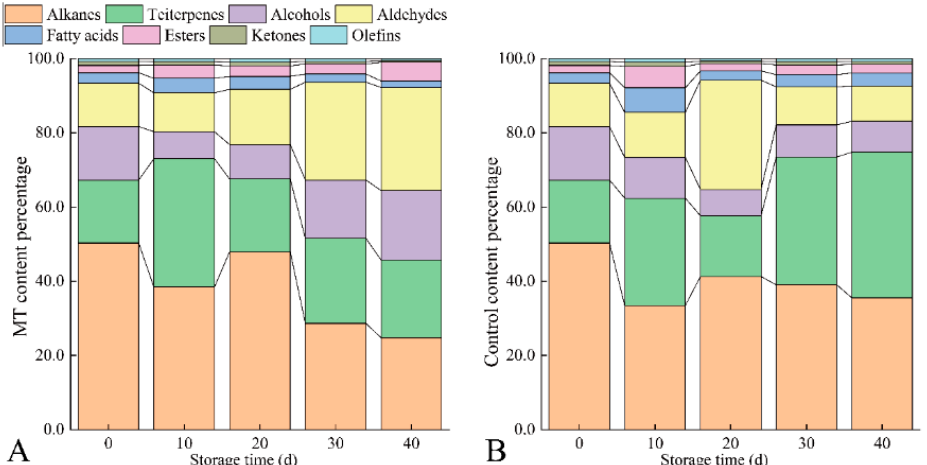
Figure 4. Melatonin treatment affects the proportion of cuticular wax in ‘Kongxin’ plum during storage. The proportion of melatonin group ( A ) and control group ( B ) cuticular wax changed during